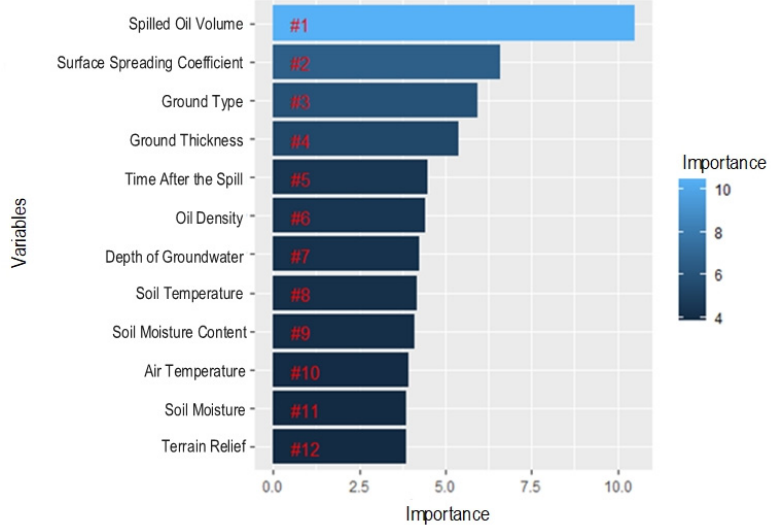
Figure 3. The ranking of variables for prediction (#1, #2, …, #12 is a number of a variable).